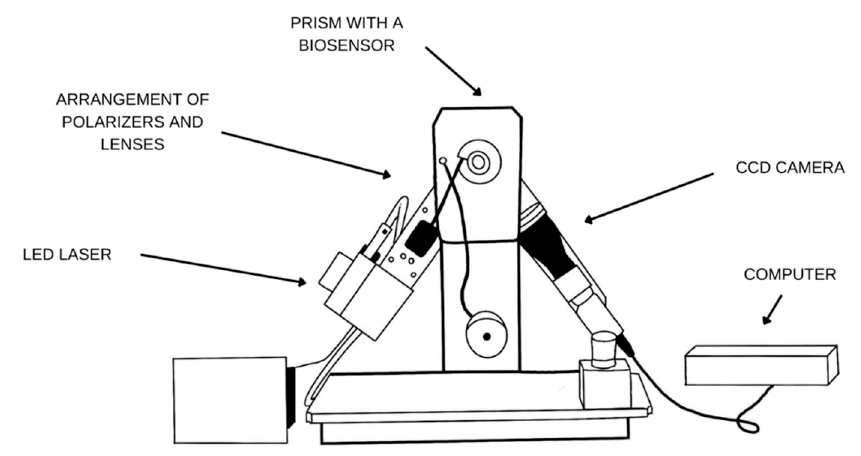
Figure A2. Diagram of the SPRi apparatus with its components.